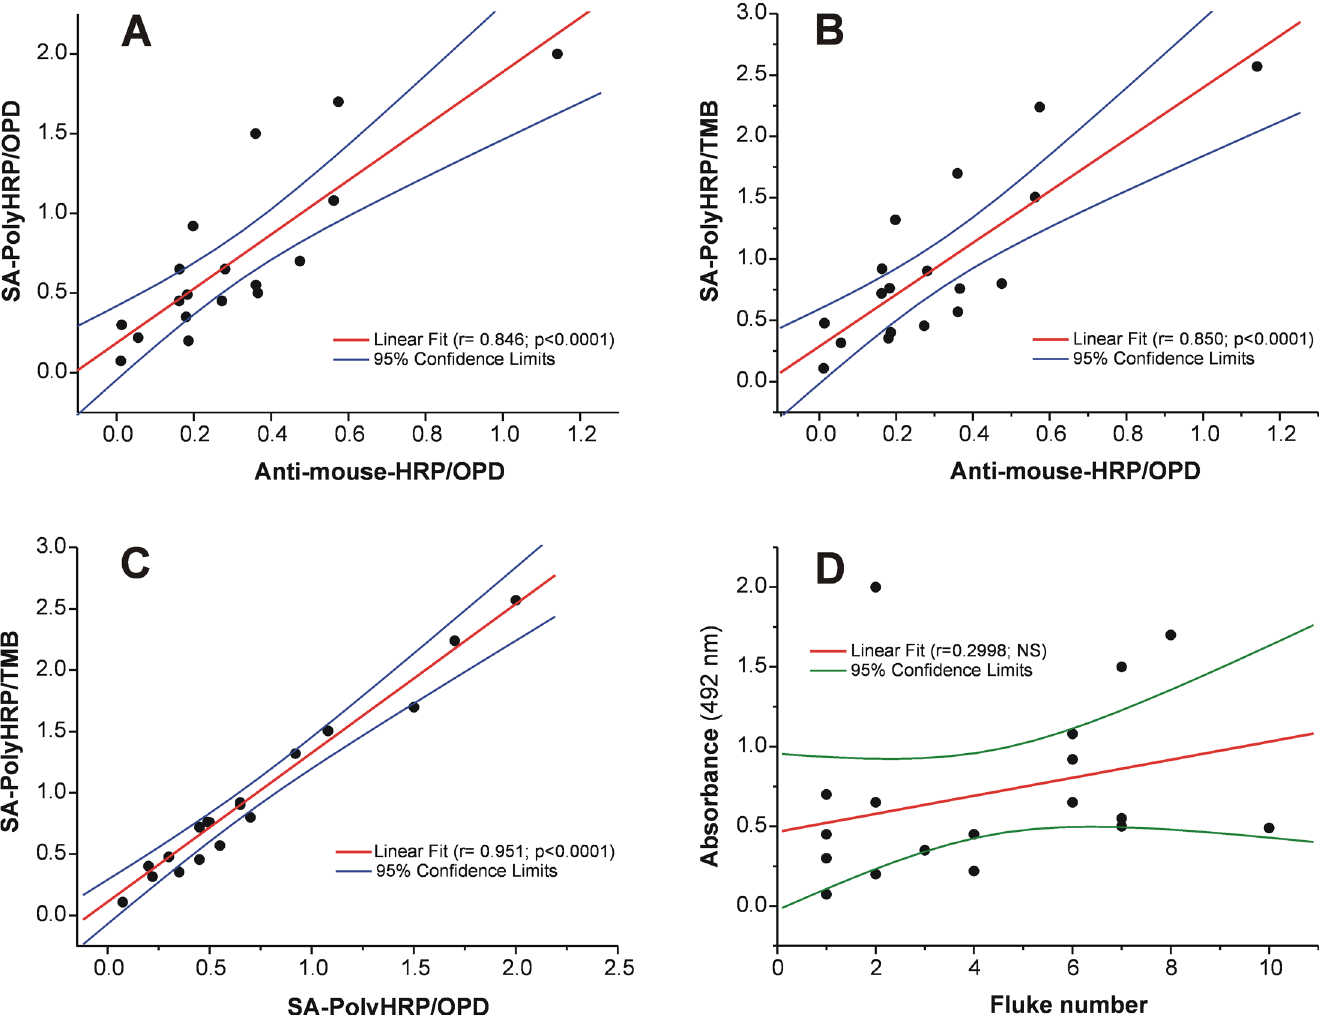
Fig 5. Correlation between MM3-COPRO models and fluke burden. Each point represents an individual cow naturally infected with Fasciola hepatica (n = 18) and tested with several variations of the MM3-COPRO test. (A) Plot of the OD values measured by MM3-COPRO model B (SA-PolyHRP and OPD, rapid incubations) against model A (HRP-labeled anti-mouse IgG antibodies, former batch, and OPD, standard incubations). (B) Plot of the OD values obtained with model C (SA-PolyHRP and TMB, rapid incubations) against model A. (C) Plot of the OD values measured by model C against model B. (D) Plot of the OD values determined by model B against the number of flukes recovered at